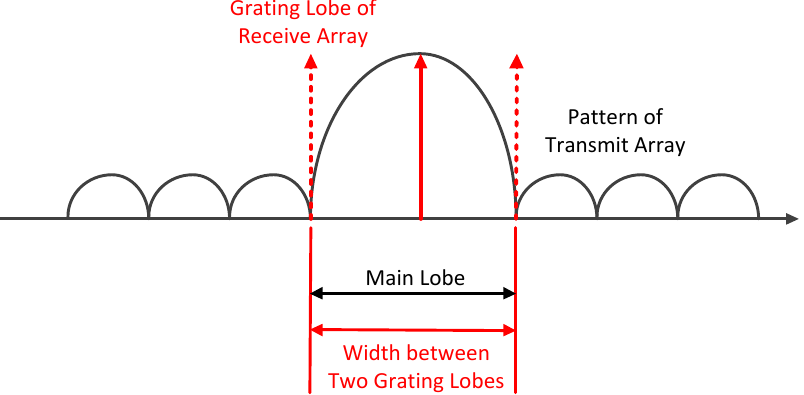
Figure 9. Description of near-field low grating lobe array.